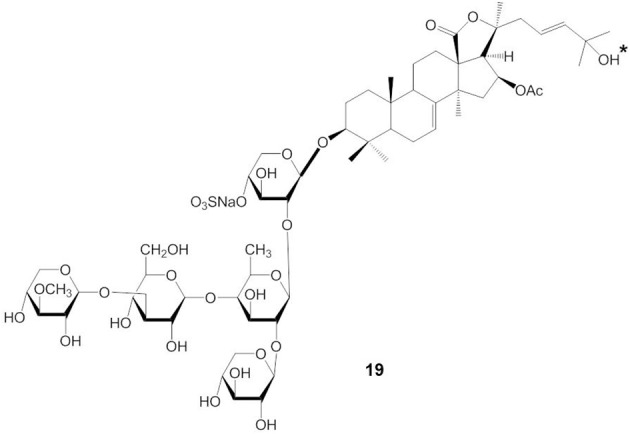
Structure of cucumarioside H2 having 25-OH group.